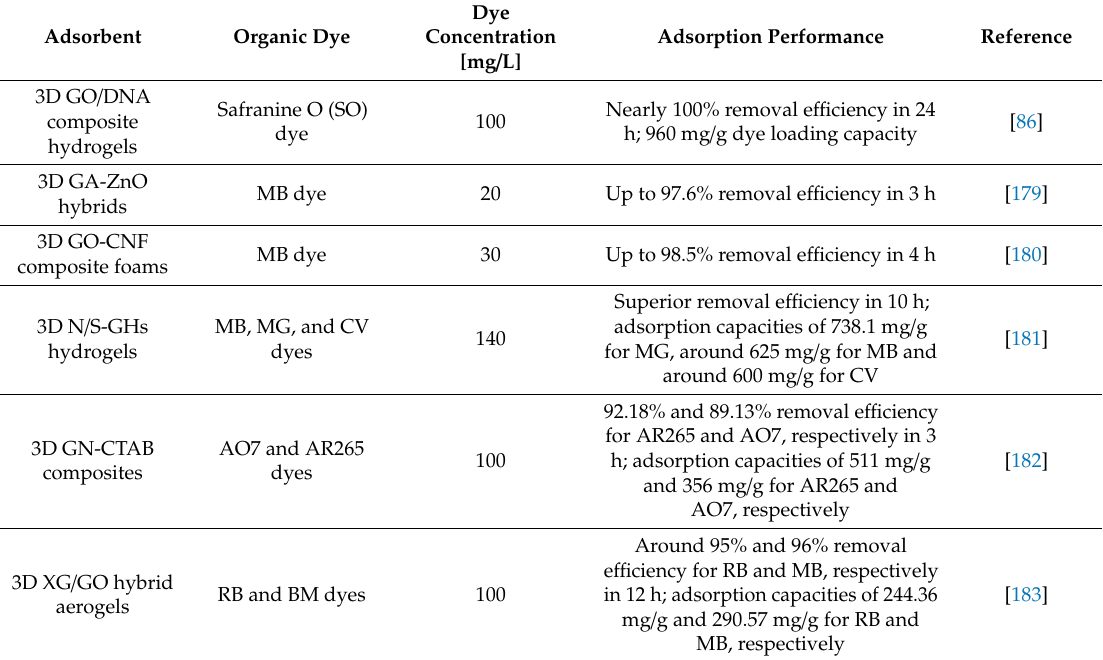
Table 1. List of 3D GBHMs utilized for eliminating organic dyes in aqueous